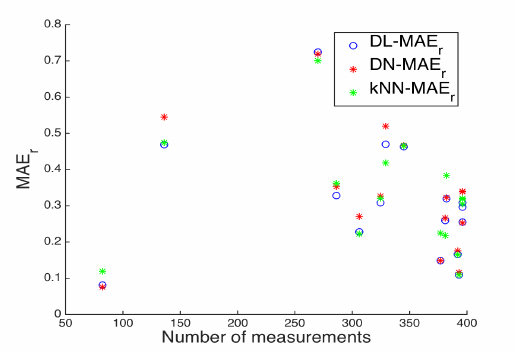
Figure 4. MAE r for different normalized numbers of measurements. DL-MAE r is for Delaunay linear, DN-MAE r is for Delaunay nearest, and k NN-MAE r is for k NN